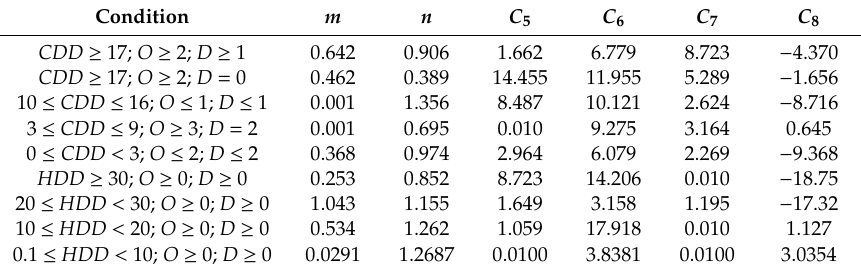
Table 2. Coe ffi cients of Equation (2) determined by the PSO method.